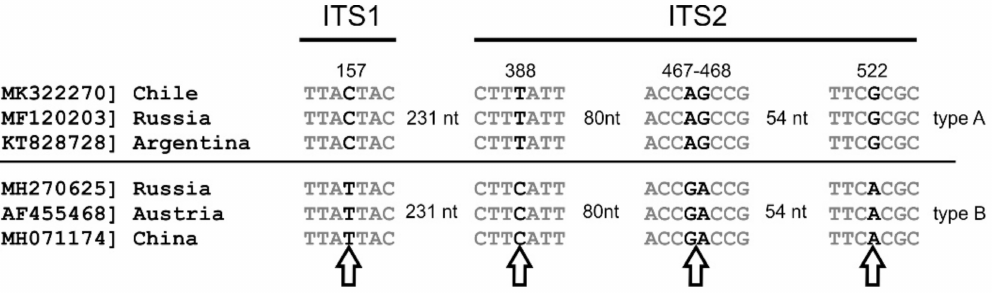
Figure 1. Variability of ITS region in Bjerkandera adusta based on alignment of sequences available in GenBank database. Polymorphic sites (marked by arrow) are shown in bold, together with nucleotide numbering according to the B. adusta strain RGM157 ITS sequence (GenBank accession number MK322270).